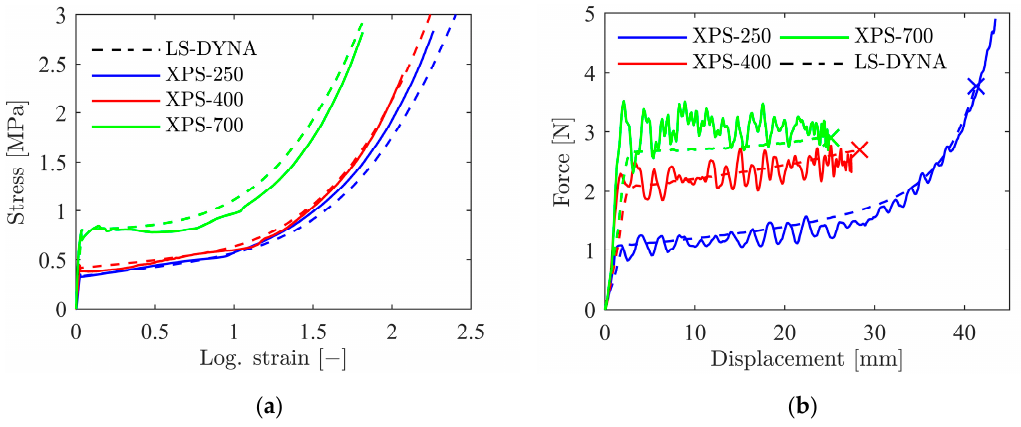
Figure 14. Comparison between experimental and numerical results for (a) quasi-static and